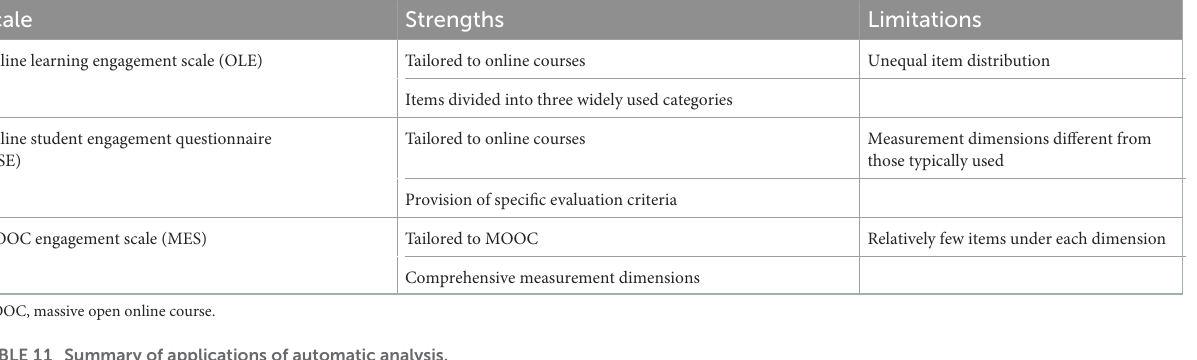
TABLE 11 Summary of applications of automatic